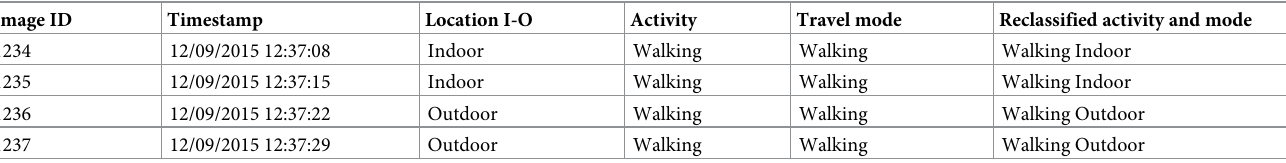
Table 3. Table of assigned labels to each of the images. Image